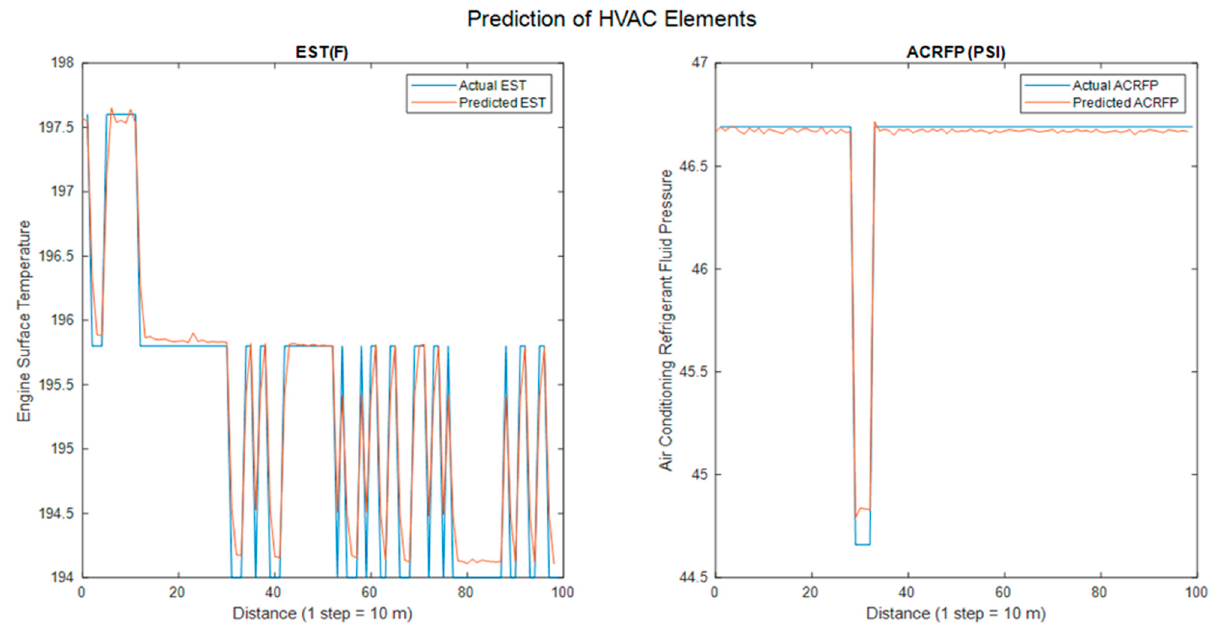
Figure 7. Prediction of CATOP—ACCSSP = 70 MPH; CAT = 72 °F; EAT = 40.1 °F.